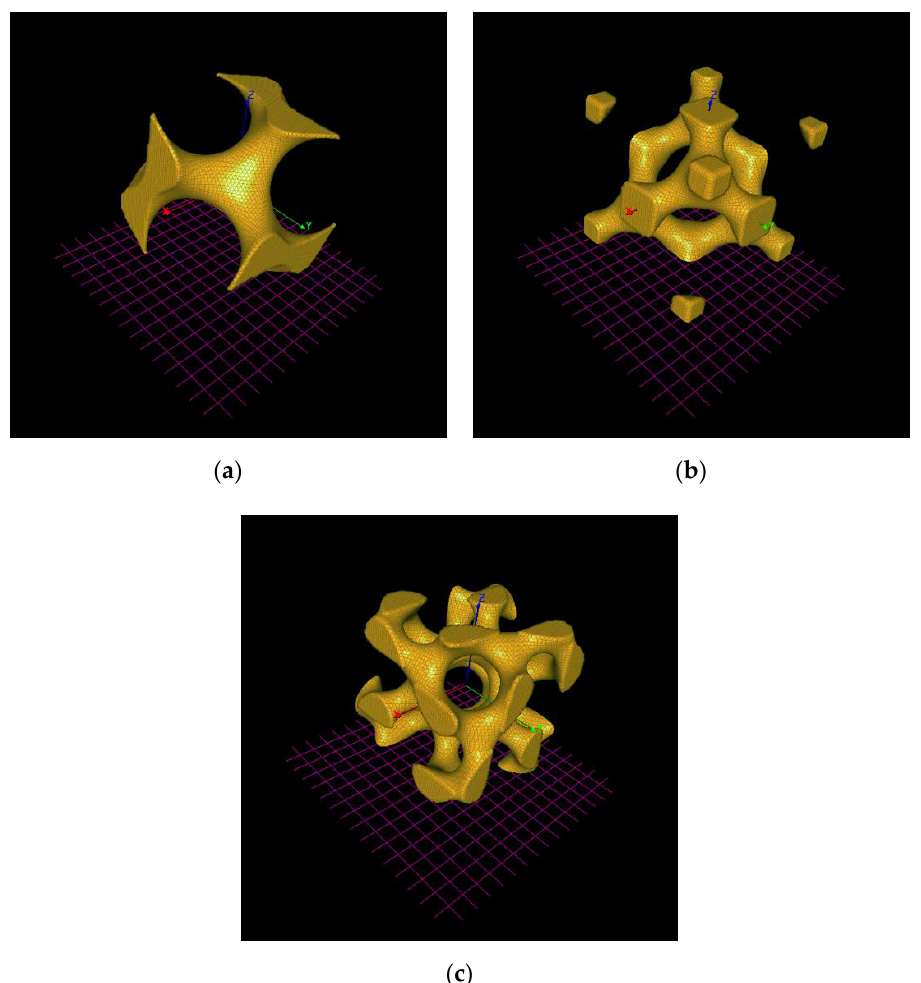
Figure 1. The triply periodic minimal surfaces (TPMS) basic unit cells libraries: ( a ) G; ( b ) D; ( c ) I-2Y. Periodic surfaces composed of simple trigonometric functions were used to approx-